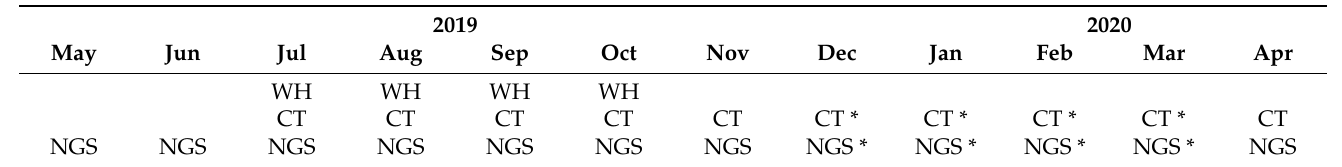
Table 1. Sampling activities from May 2019 to April 2020: WH = wolf howling, CT = camera trapping, NGS = non-invasive genetic sampling.